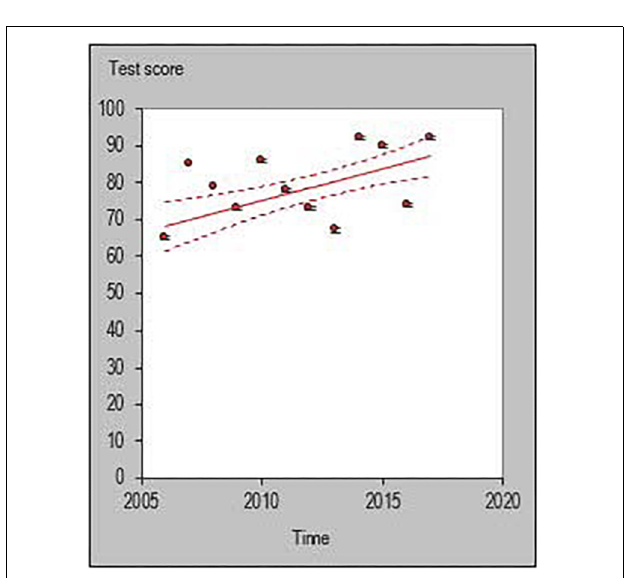
FIGURE 6 | Individual trend of one participant for free throw percentage per season.